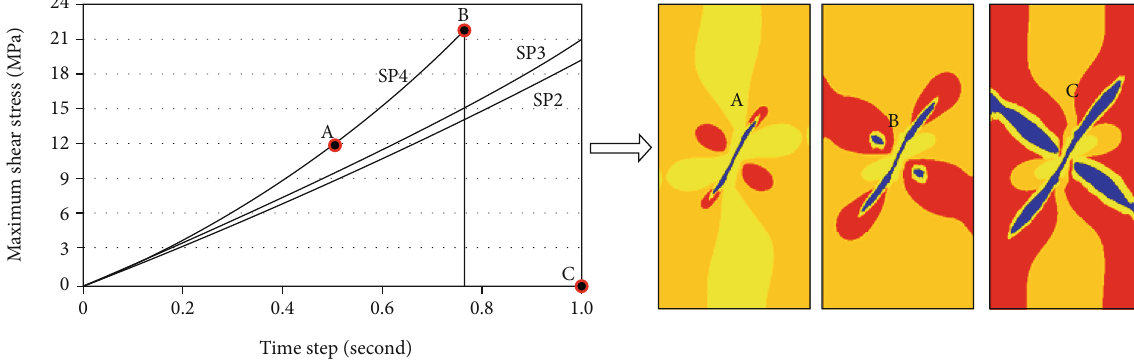
Figure 7: Shear-stress evolution of the initial cracks in the second